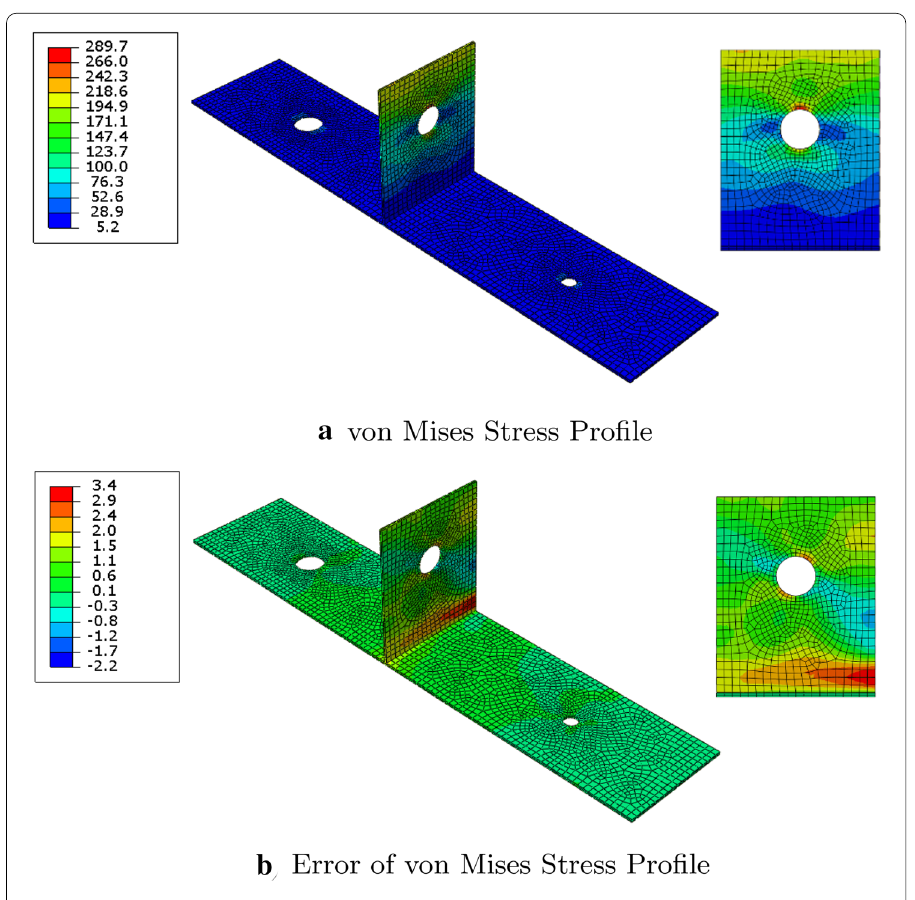
Fig. 10 Single webbing hole feature model results in